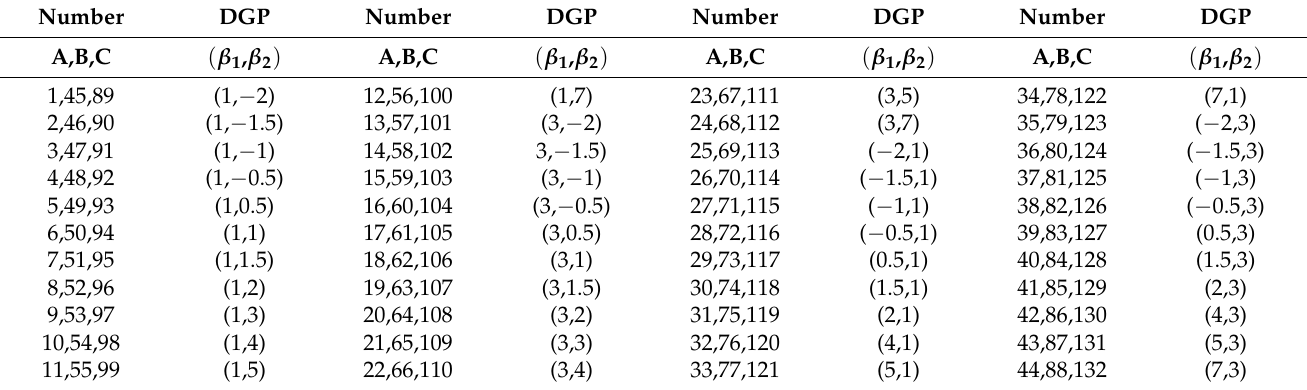
Table 3. Number of every experiment in Case 2, and types of x in the DGP (A,B,C) 1 .